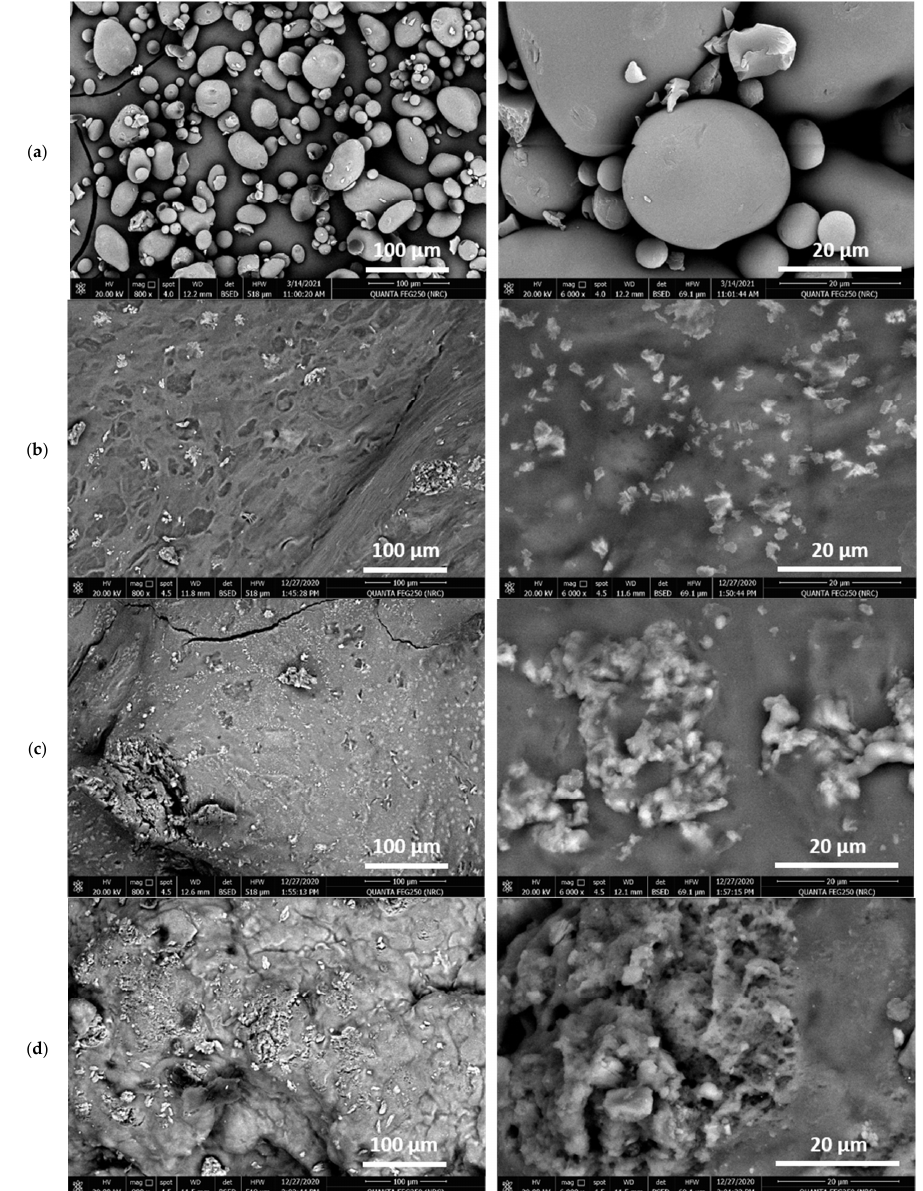
Figure 3. Micrographs for the prepared materials and hydrogel; ( a ) CMP, ( b ) Pe@CMP1, ( c ) Pe@CMP2 and ( d )